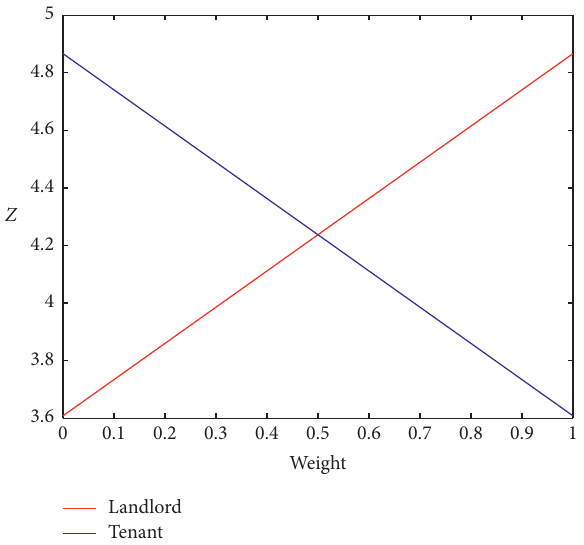
Figure 9: Influence of the weight of the SAD on the overall sat- isfaction value Z .